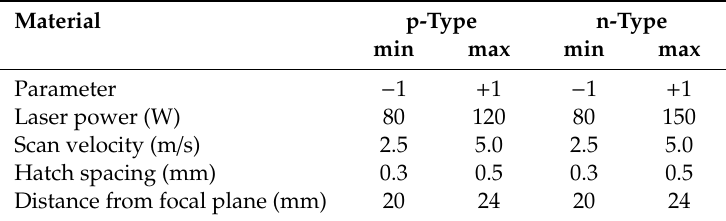
Table 3. Parameter matrix for Design of Experiment (DoE) factorial